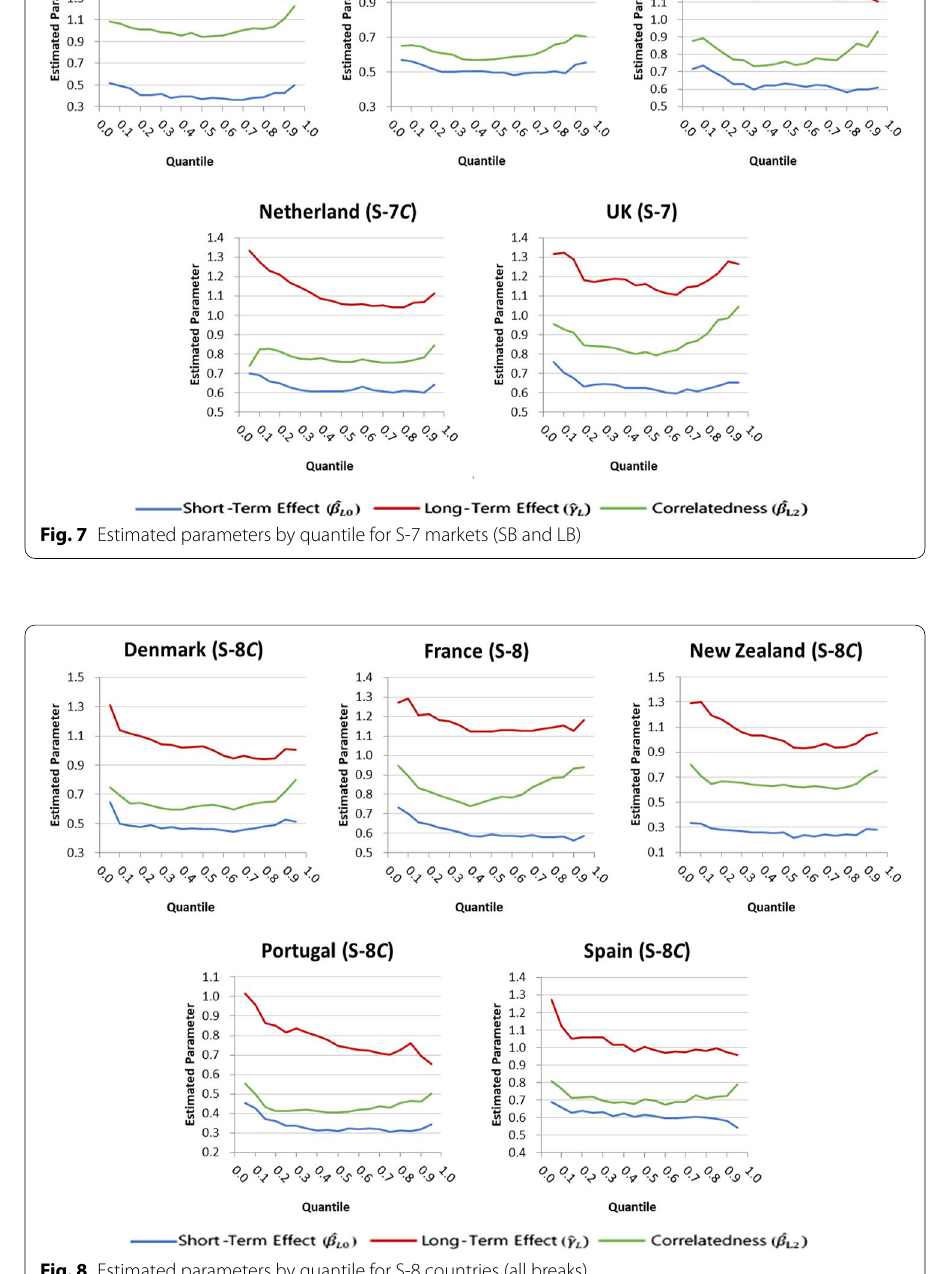
long-term effect (red lines), correlatedness (green lines), and short-term effect (blue lines) tended to show a decrease, that is, slowdown in comovement and MSR at the 5th quantile. S-2 markets The equity market returns for Germany and Sweden can be categorized as S-2. These markets suffered from a correlatedness break without short- or long-term